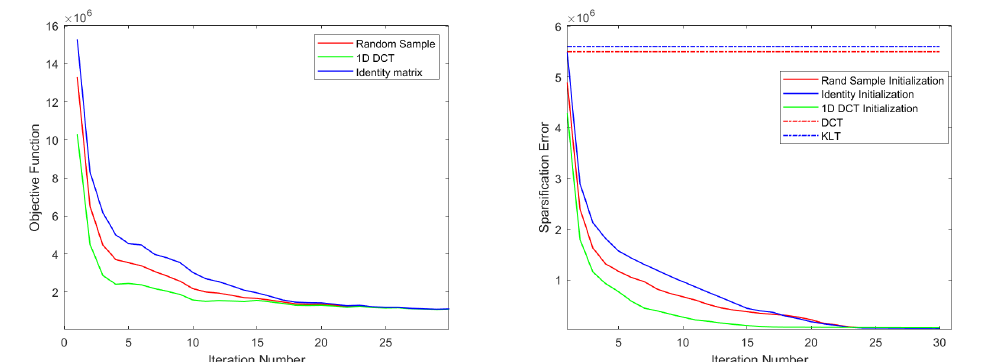
Figure 5. Convergence Curve and Sparsification Error. Left : The X -label is the iteration number. Right : The Y -label is the objective function and the sparsification error, respectively. It can be seen that our DRTPF learning algorithm is convergent and insensitive to initialization.